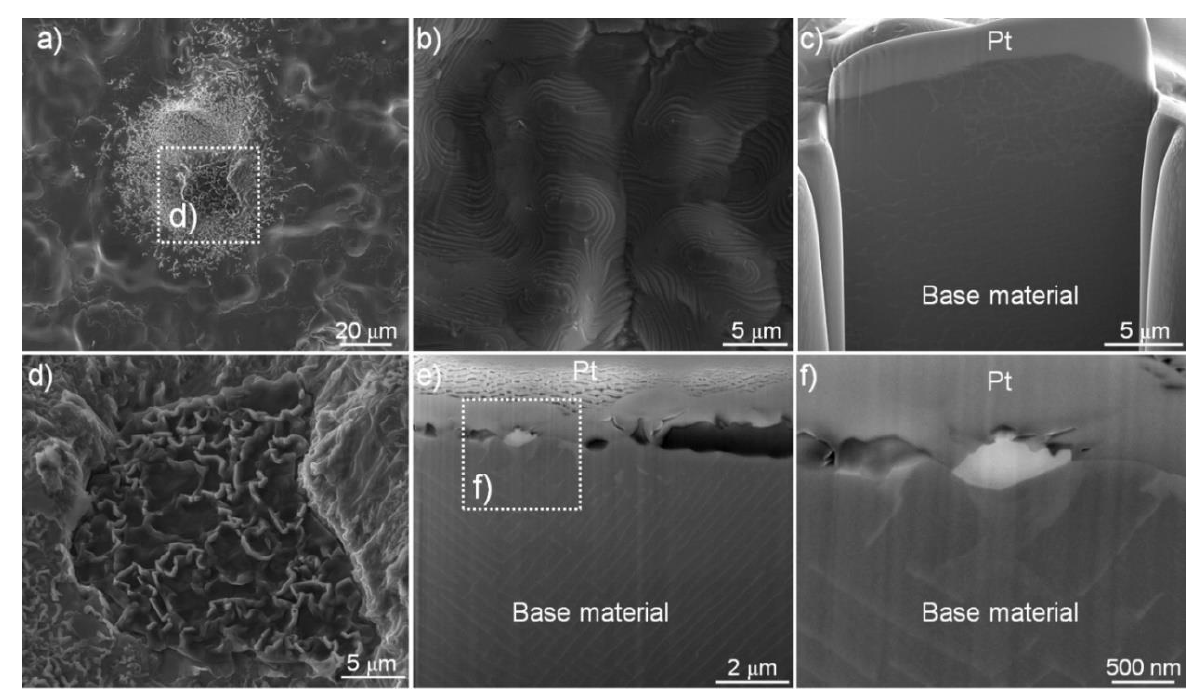
Figure 2. SEM images in a scaled region: ( a ) a low magnification plain view showing an interested region, ( b , c ) a magnified plain view image ( b ) and a tilting view image after a FIB milling process ( c ) of a normal area, ( d ) a magnified plain view image at the marked region in panel ( a ), ( e ) a tilting view image near the boundary region in ( d ) after FIB milling, and ( f ) a magnified image at the marked region in ( e ). Note that the surface of interest in ( b ) and ( d ), respectively, was protected by a platinum deposition layer before FIB milling.